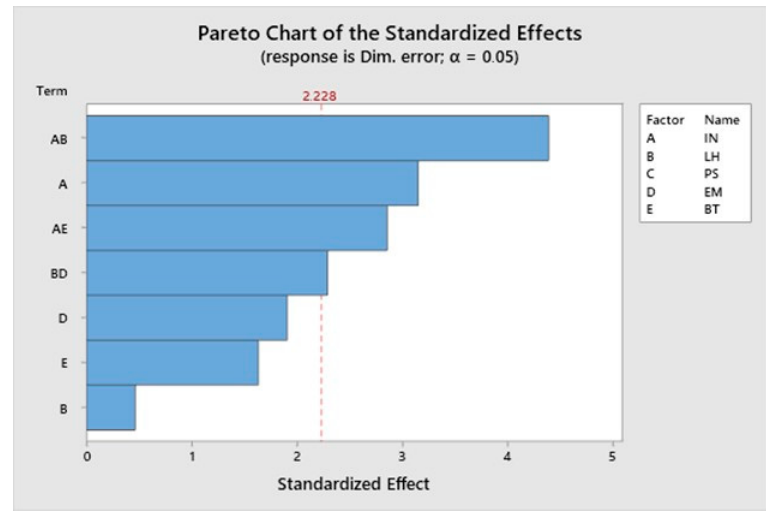
Figure 3. The Pareto chart of the standardized effects for average dimensional error.